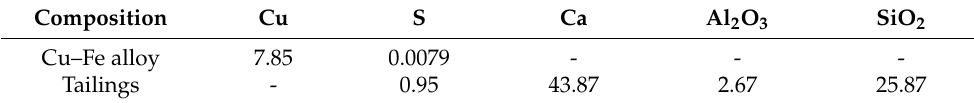
Table 3. The composition of Cu–Fe alloy and tailings after desulfurization by CaC 2 (wt.%).